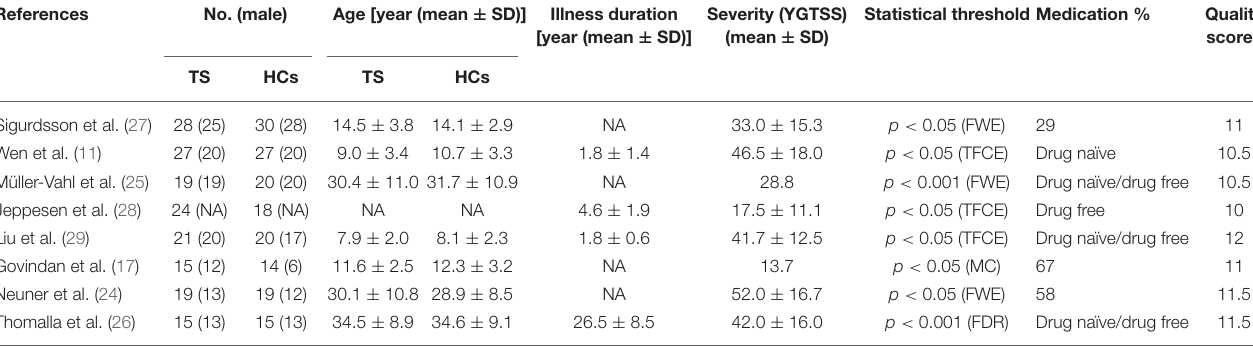
TABLE 1 | Demographic and clinical characteristics of the participants in the eight studies included in the